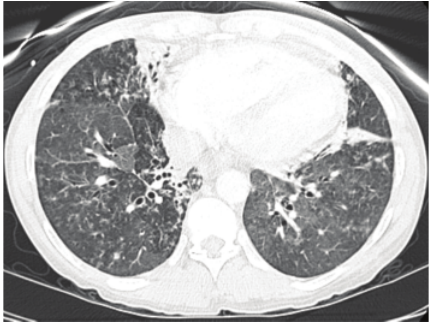
Figure 2: Haematoxylin and eosin stain of the left lobe biopsy showing extensive interstitial infiltrates and germinal